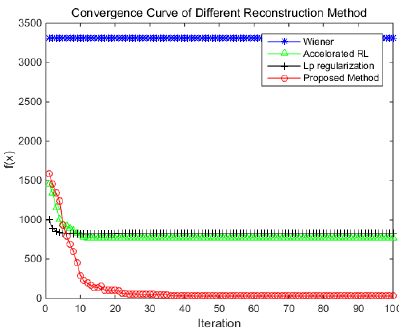
Figure 18. The convergence curve of different